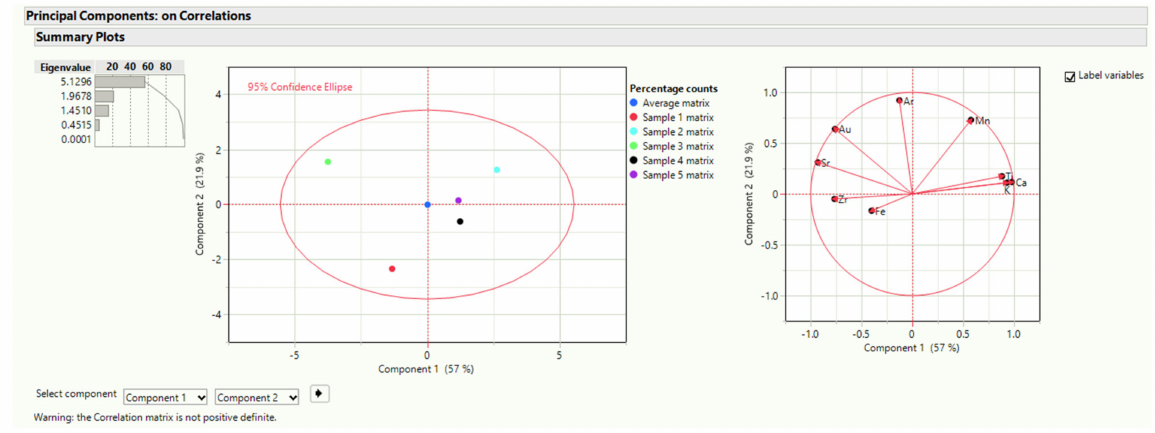
Figure 4. Principal component analysis of terracotta